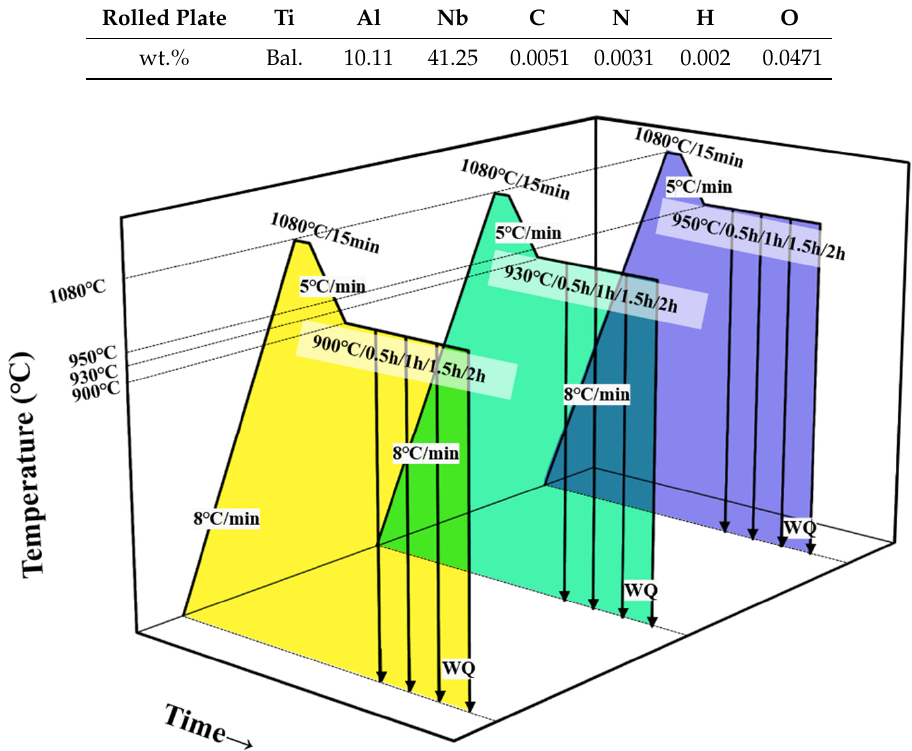
Figure 1. The schematic illustration of the heat treatment process.